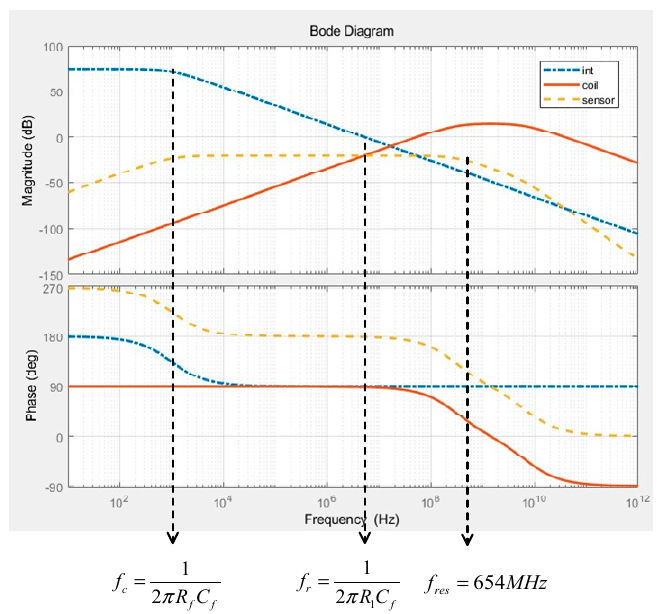
Figure 10. Frequency response characteristics of the current sensor.